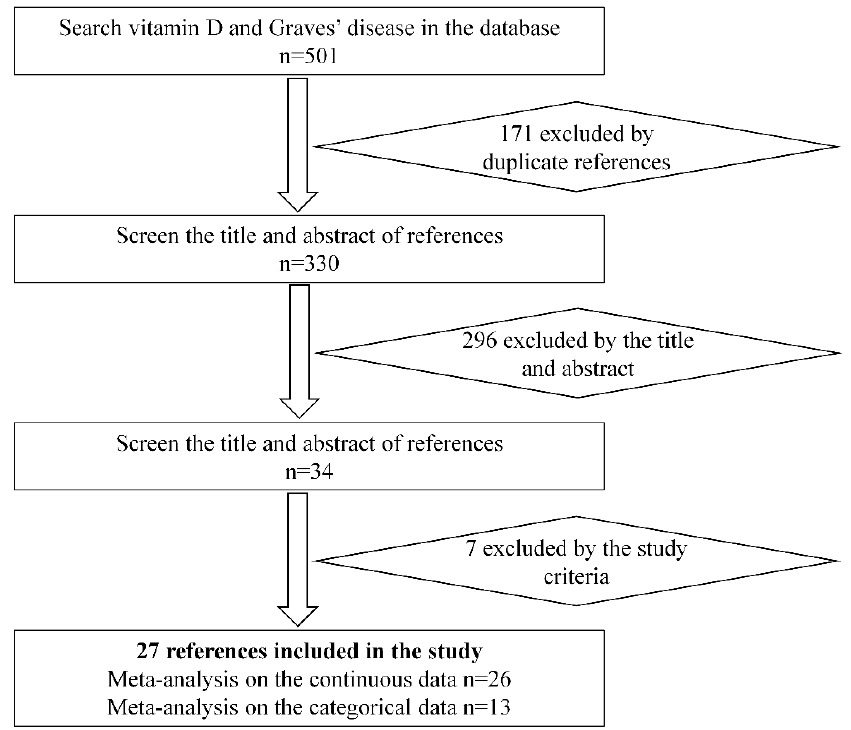
Figure 1. The flow diagram of the study